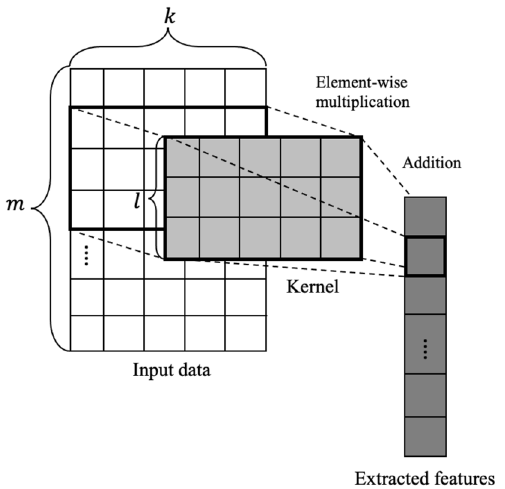
Figure 1. A depiction of the 1-D convolution operation, which employs a kernel of the same width as the input. This kernel performs convolution operations as it traverses the length of the